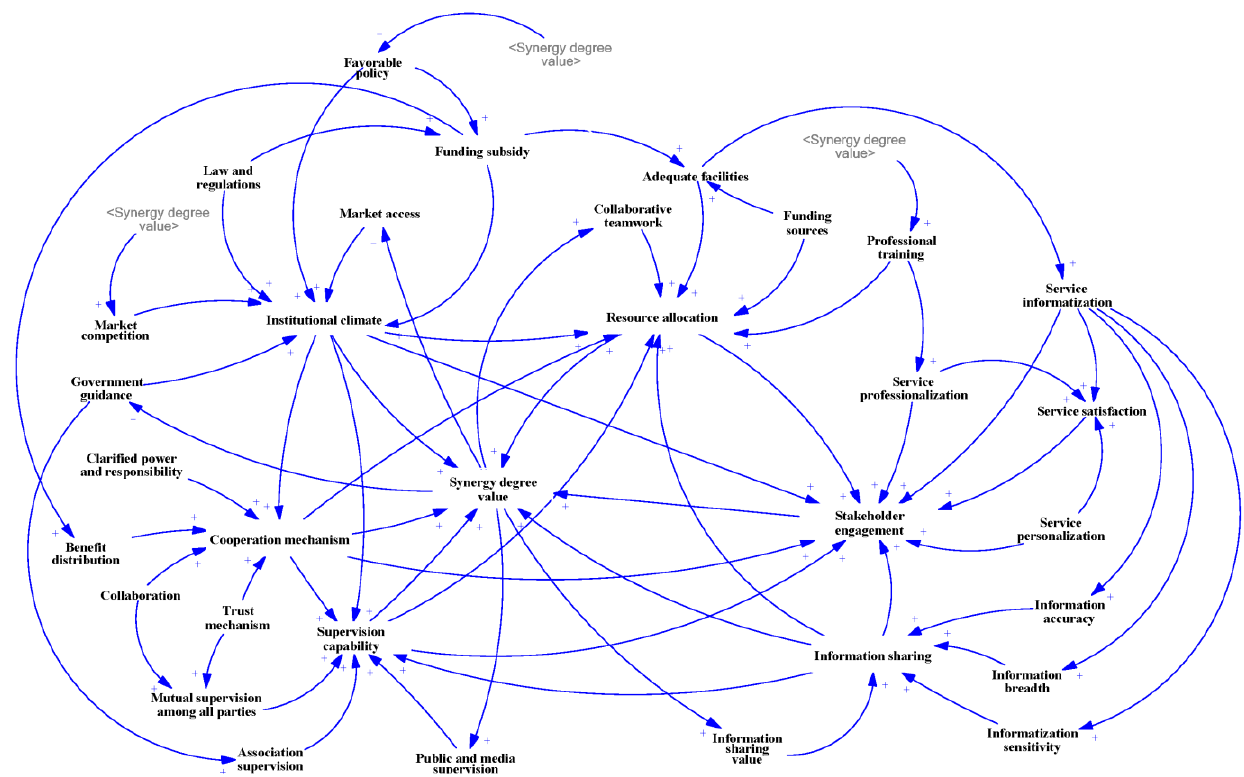
Figure 8. The whole causal-loop diagram.